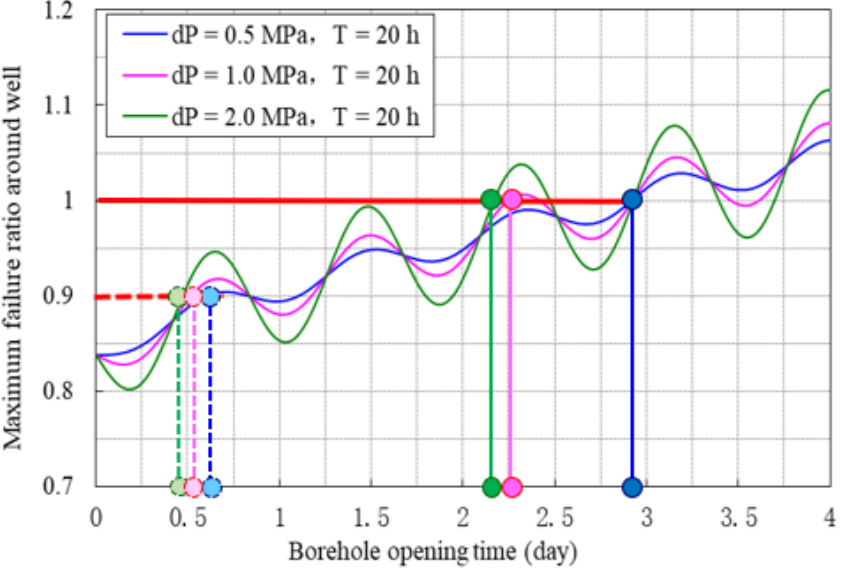
Figure 6. Formation maximum failure ratio change under pressure variation (constant period).